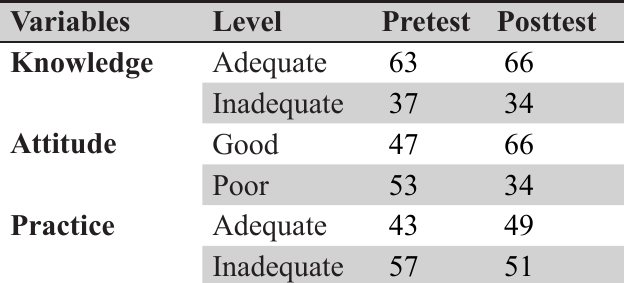
Table 3. Comparison of Level of Pretest and